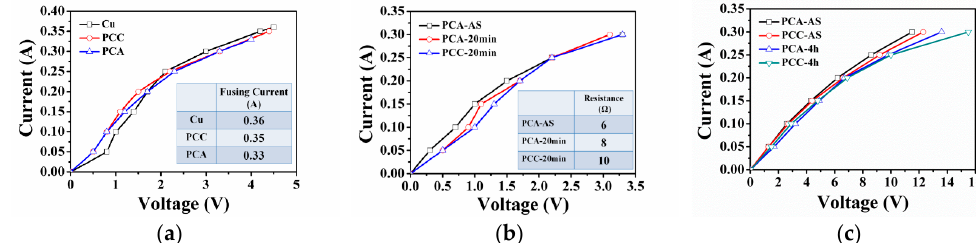
Figure 3. Electrical properties of PCC and PCA wires ( a ) before and ( b ) ( c ) after sulfidation.